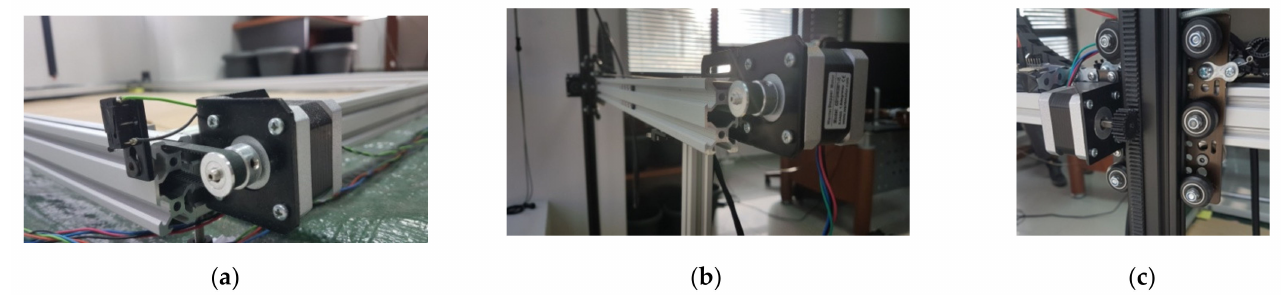
Figure 5. Detailed view of the motors of: ( a ) X axis (1 of the 2); ( b ) Y axis and; ( c ) Z